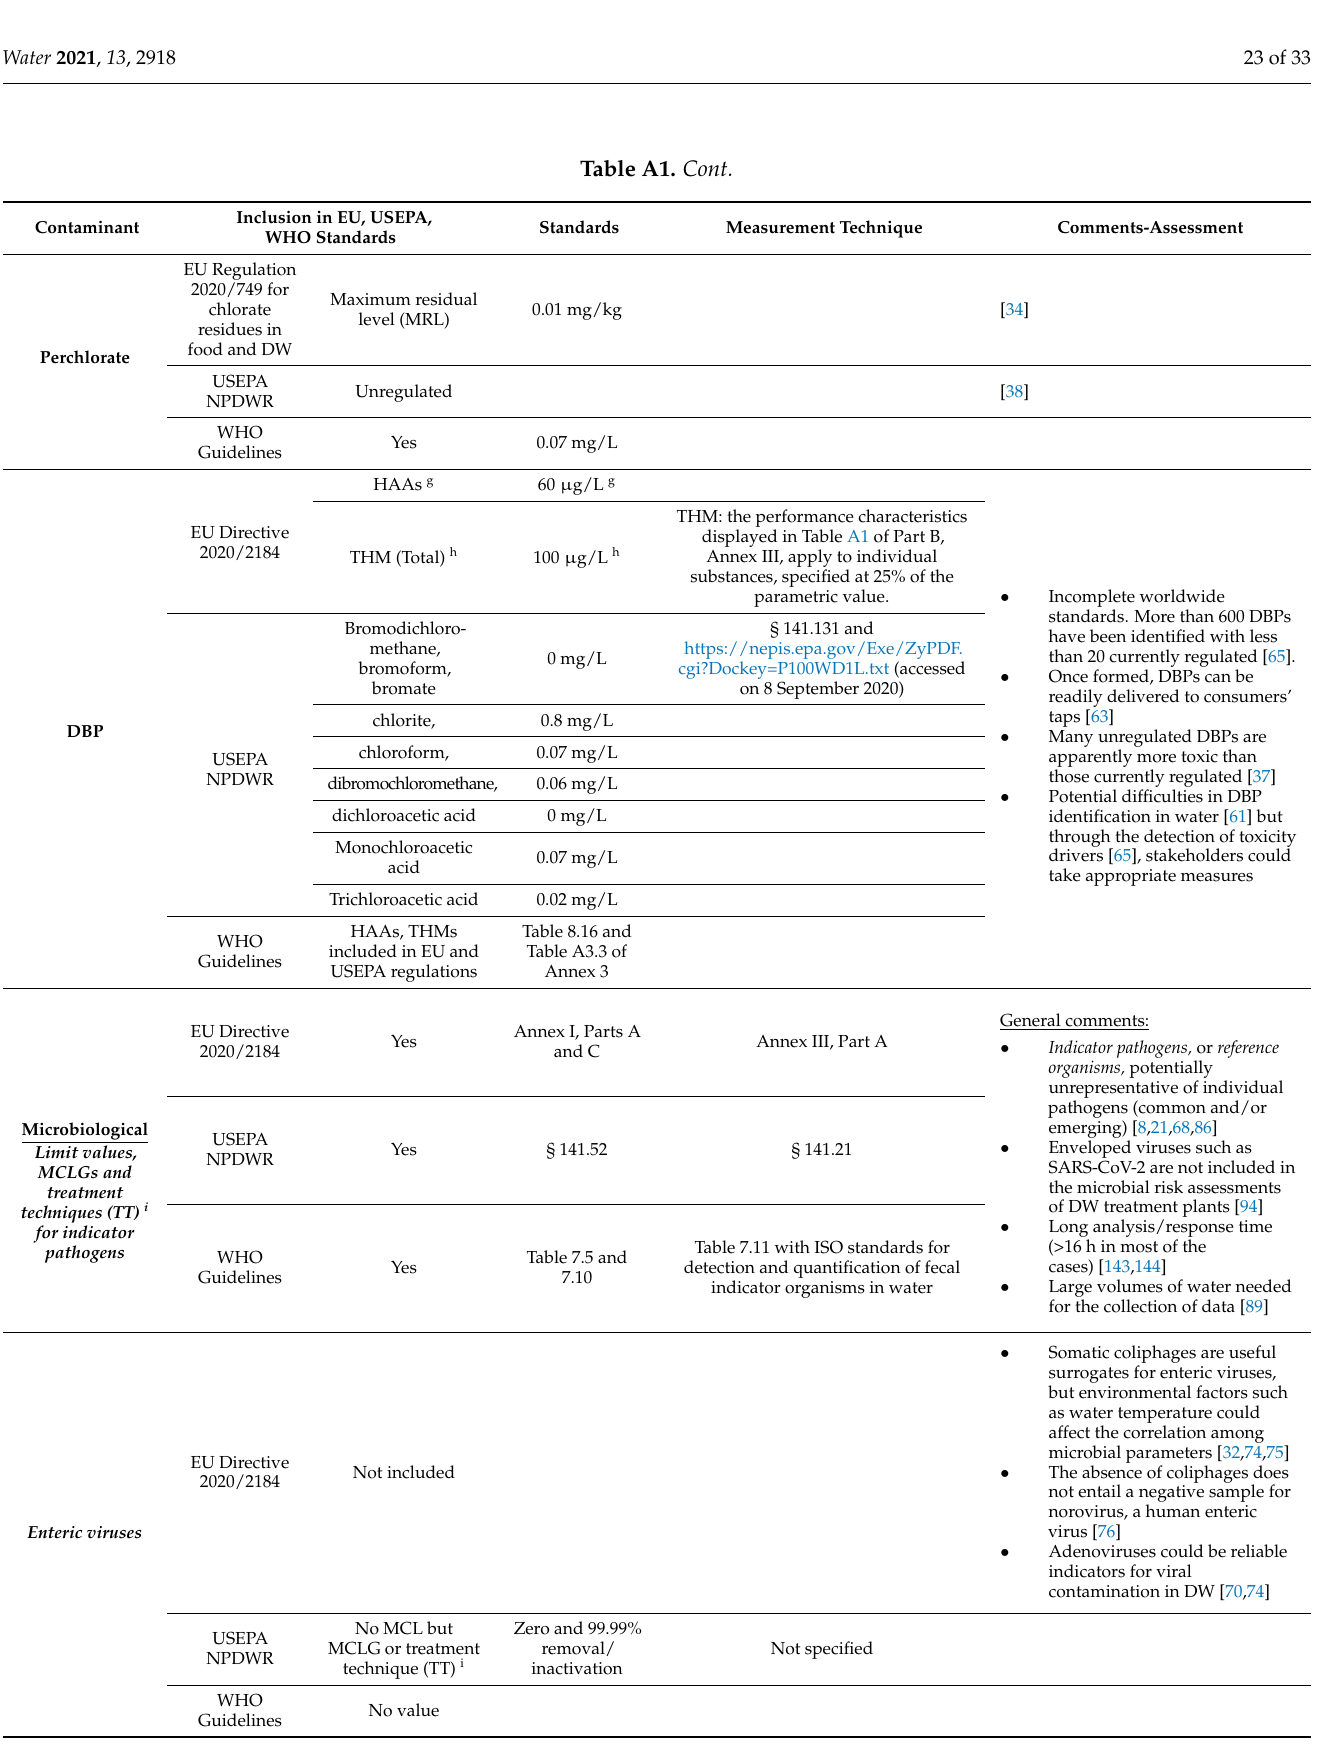
Table 7.11 with ISO standards for Table 7.5 and detection and quantification of fecal 7.10 indicator organisms in